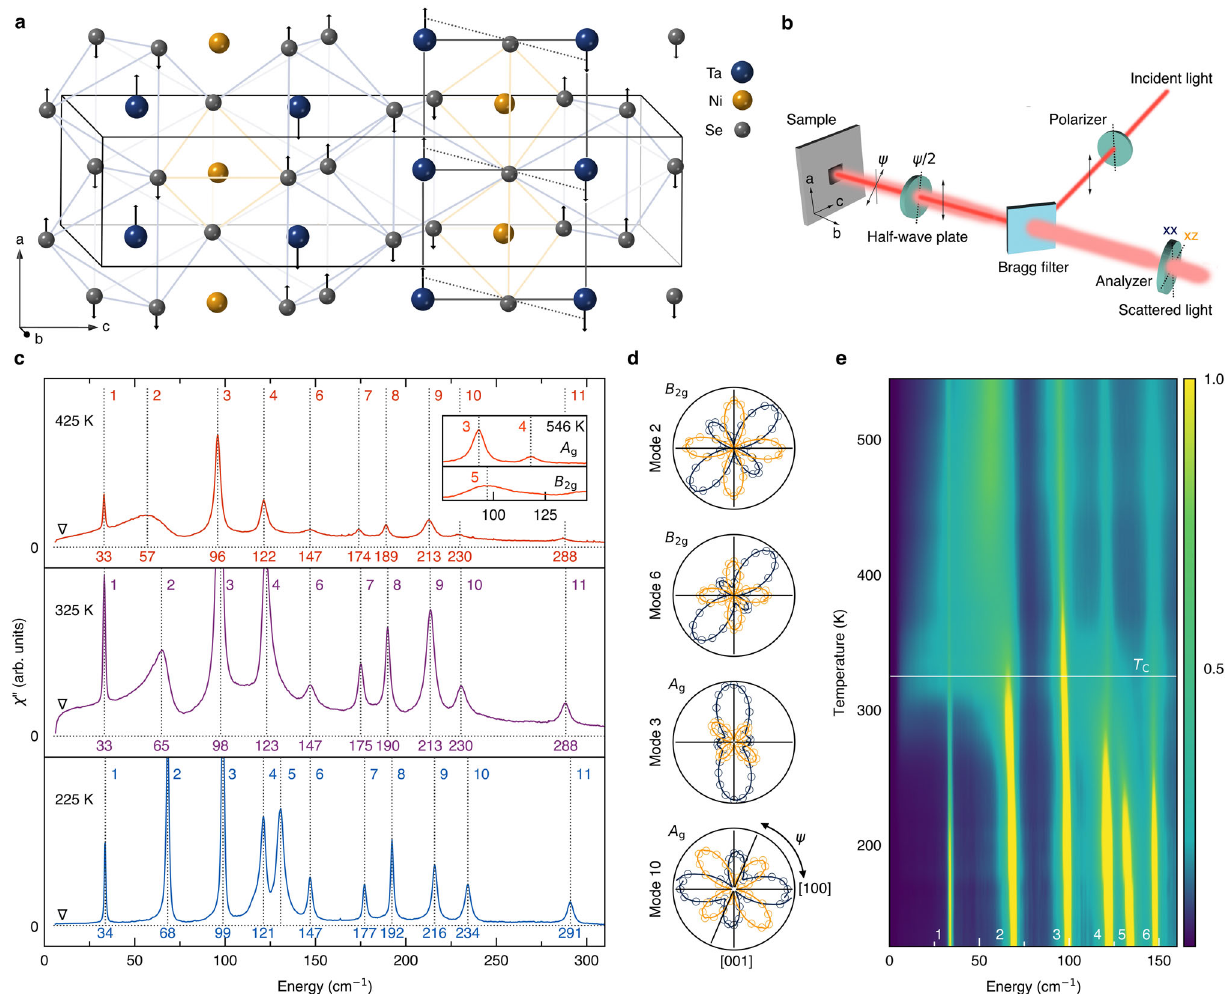
Fig. 1 Raman-active phonon modes and a quasi-elastic peak. a Crystal structure of Ta 2 NiSe 5 , overlaid with the displacement vectors (×50) in the orthorhombic-to-monoclinic transition. The black solid box shows the unit cell. The gray solid and dotted lines visualize the shearing of the quasi-one- dimensional Ta-Ni-Ta chain along the a -axis by the monoclinic distortion. b Experimental con fi guration of the Raman measurements. c , Unpolarized Raman spectra at T = 225 K (blue), 325 K (purple), and 425 K (red). All of the eleven Raman-active modes are labeled in the order of increasing energy, and the quasi-elastic peak (QEP) is marked by an inverted triangle. The inset shows symmetry-resolved Raman spectra at T = 546 K. d Azimuth-angle dependence of the polarization-resolved Raman scattering intensity. Ψ measures the angle between the a -axis and incident polarization, and navy (yellow) color represents the scattered-light polarization parallel (perpendicular) to the incident one. The A g ( B 2 g ) spectrum in the inset of ( c ) is isolated by measuring in the cross-polarization channel at Ψ = 45 ∘ ( Ψ = 0 ∘ ). e False color map of the unpolarized Raman spectra from 120 to 550K. T C = 325 K is indicated by the white horizontal